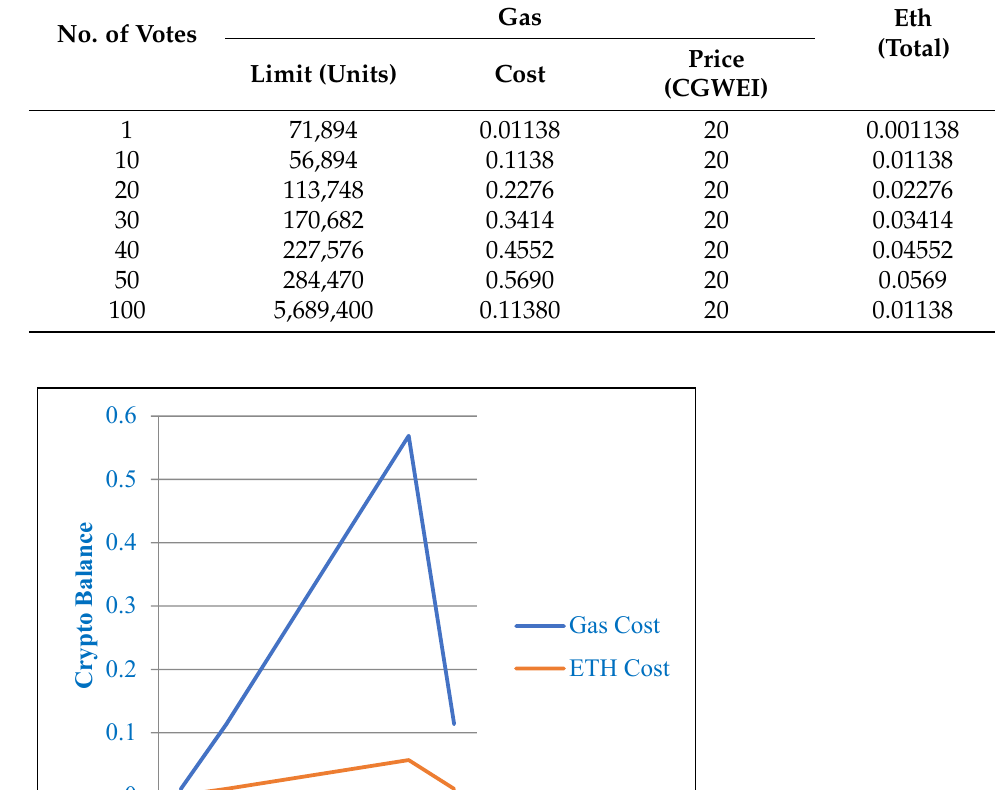
Table 3. Eth consumption for votes.